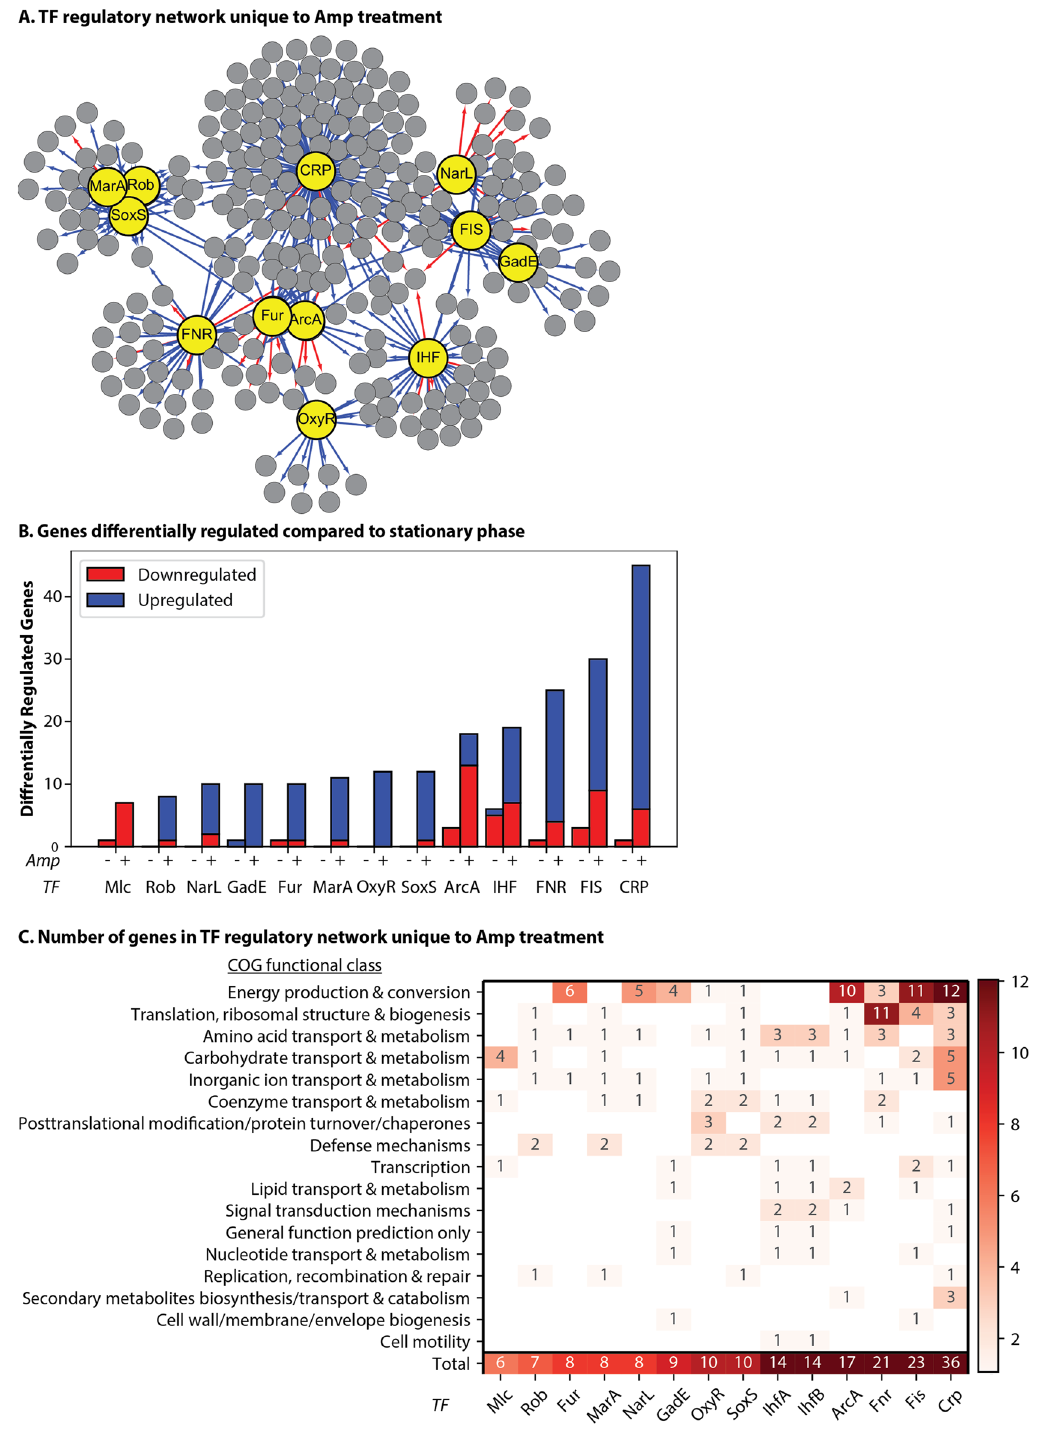
Figure 3. TFs associated with antibiotic tolerance are more active in the ampicillin treated population. TFs act as transcriptional regulators that control a several redundant and overlapping pathways related to antibiotic stress. Genes with changes in expression over two-fold (adjusted p < 0.1) were mapped to TFs responsible for their transcription. ( A ) A graphical representation of the selected TF regulatory network during antibiotic tolerance inferred from changes in gene expression unique to the ampicillin treated population compared to stationary phase (File S3). Red lines: decreased expression. Blue lines: increased expression. Large yellow circles: select TFs. Small grey circles: genes regulated by select TFs. ( B ) Counts of differentially regulated genes for the untreated and treated populations compared to stationary phase. Selected TFs displayed a significant difference (p < 0.05) in the number of genes that changed expression when comparing untreated (Amp-) and treated (Amp+) groups based on the Fisher’s exact test. Amp- (untreated): cells incubated for 3 h in fresh media without ampicillin. Amp+ (treated): cells incubated for 3 h in fresh media with ampicillin. Genes with multiple possible TFs are accounted for each possible TF. ( C ) Changes in gene expression for the select TFs based on COG functional group; genes uncharacterized by REF 44 were not included. A high number of genes differently expressed are specific to a few